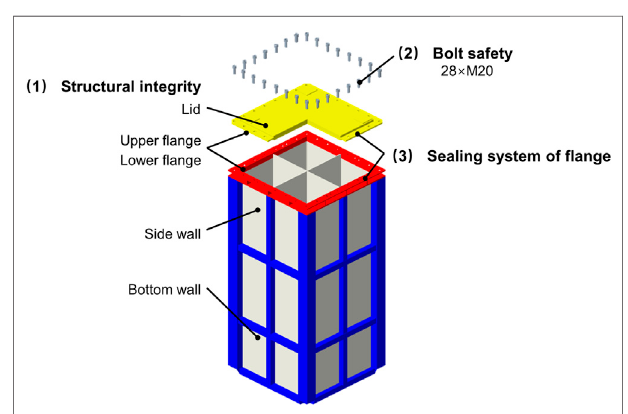
FIGURE 4 | Assessment criteria for containment